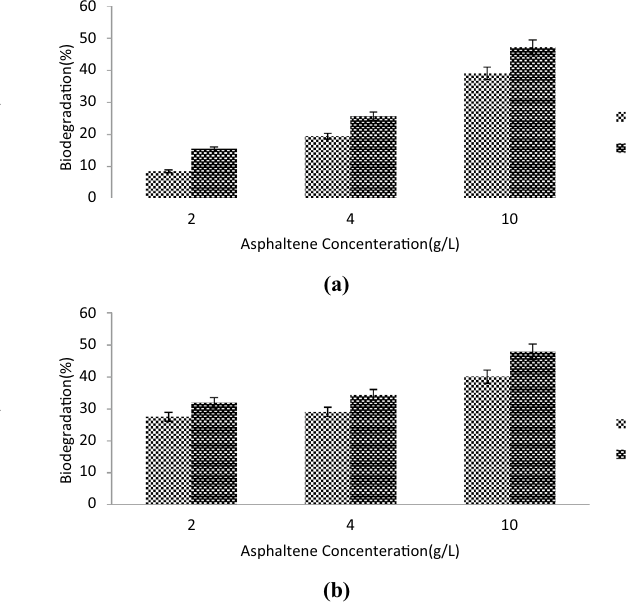
Fig. 5 Biodegradation of three types of microorganisms at different initial Ahwaz-Bangestan asphaltene concentrations; a without SDBS presence and b with SDBS presence